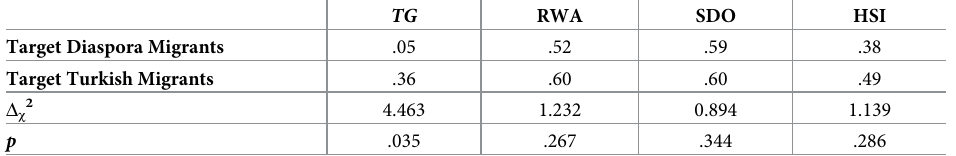
Table 1. TG, RWA, SDO, and HSI as predictors of derogation of diaspora migrants as opposed to Turkish migrants. TG RWA SDO HSI Target Diaspora Migrants .05 .52 .59 .38 Target Turkish Migrants .36 .60 .60 .49 Δ χ 2 4.463 1.232 0.894 1.139 p .035 .267 .344 .286 TG = Perception of the group as Transgenerational; RWA = Right-Wing Authoritarianism; SDO = Social Dominance Orientation; HSI = Hierarchic